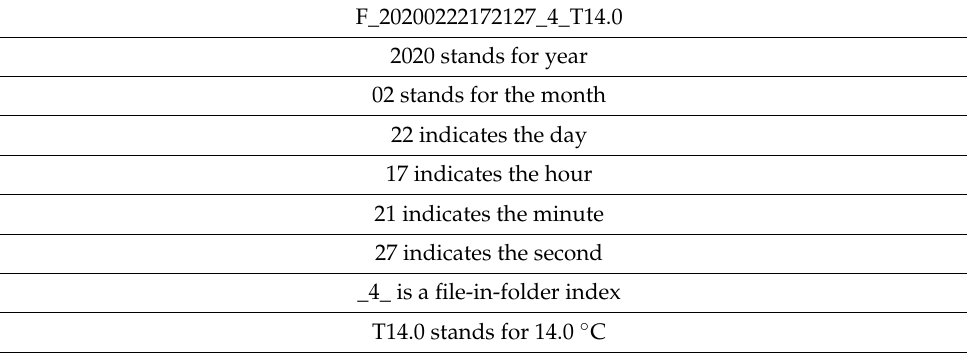
Table A3. The Structure of A Typical Filename: